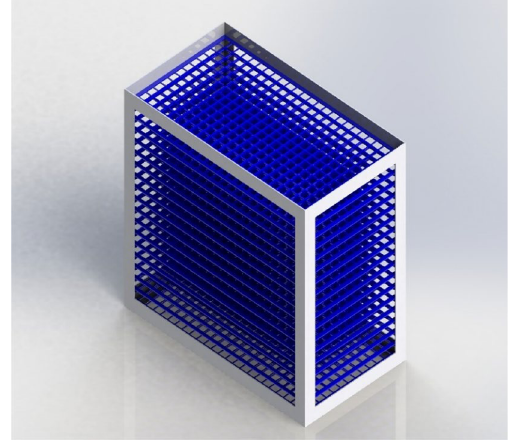
Figure 2. Schematic of the used filled bed.